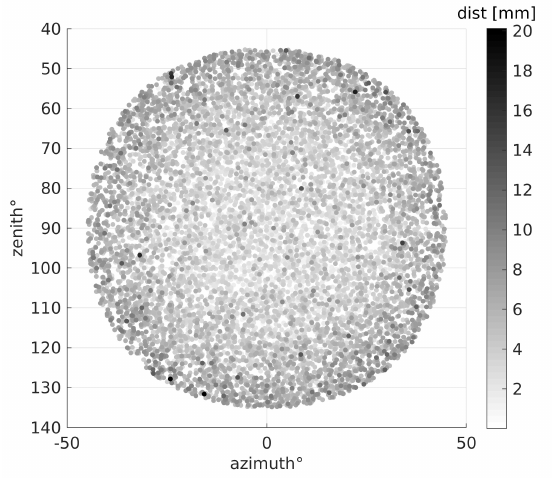
Figure 6. Distribution of the distance between muon exit point from the radiator and centroid of the 2D-Gaussian fit as a function of the polar angles in the reference system of the particle source. The plots refer to a scenario with radiator thickness equal to 20mm and an array of 16 × 16 SiPMs; the kinetic energy of muons at the source is 10 4